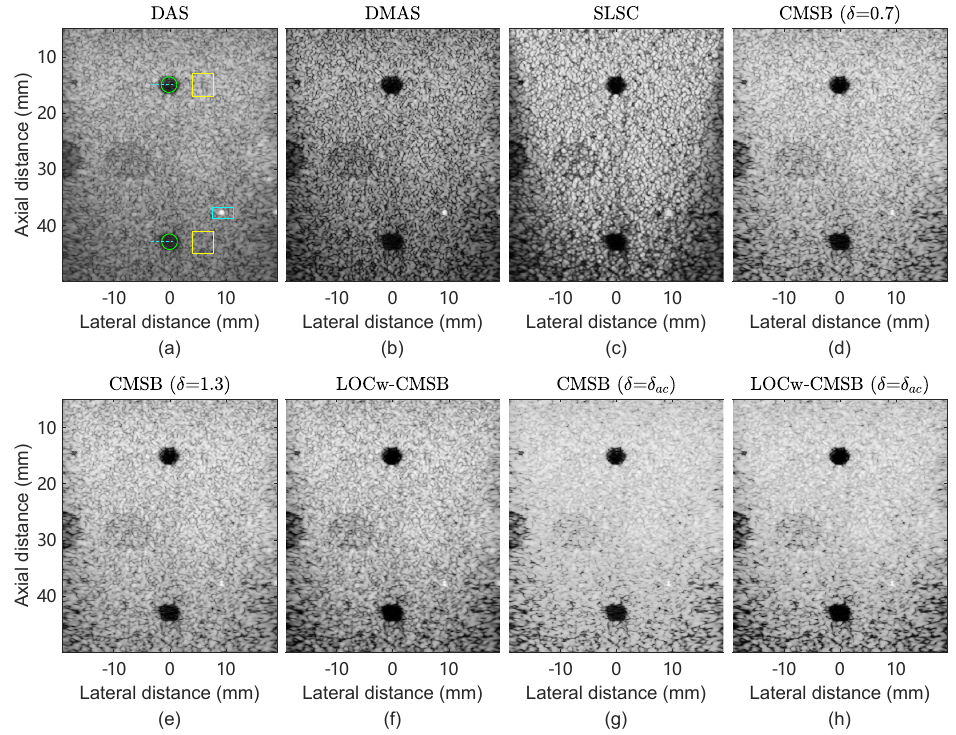
Figure 6. Experimental cyst phantom images reconstructed by ( a ) DAS, ( b ) DMAS, ( c ) SLSC, ( d ) CMSB ( δ = 0.7), ( e ) CMSB ( δ = 1.3), ( f ) LOCw-CMSB, ( g ) CMSB ( δ = δ ac ), and ( h ) LOCw-CMSB ( δ = δ ac ). Figure 7 plots the lateral variations through the point target indicated by the cyan box, and the two cyst targets are indicated by cyan dashed lines in the experimental cyst images. As can be seen, CMSB ( δ = 0.7) obtains a narrower mainlobe compared with DMAS, and other CMSB-based methods all obtain the narrowest mainlobe. This indicates the maintained resolution performance of enhanced CMSB methods. In addition, LOCw- CMSB and LOCw-CMSB ( δ = δ ac ) obtain the lowest noise level in cyst targets, which is lower than that of DMAS, and have the best edge resolution according to Figure 7b,c.